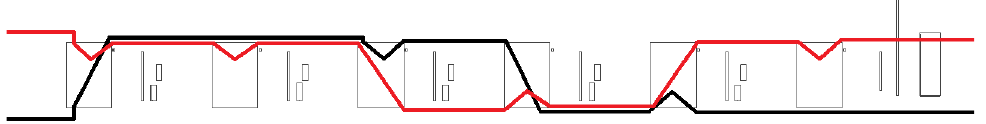
Figure 11: The pipe configurations for the 3 scenarios.